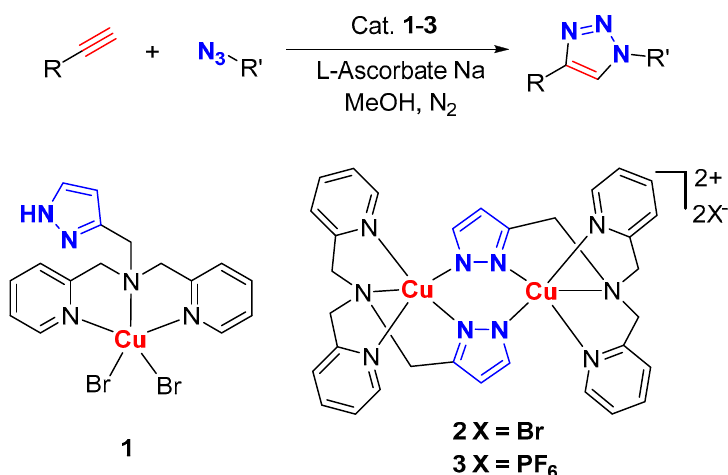
Scheme 1. Cu complexes bearing an unsymmetrical bipyridine-pyrazole-amine ligand and application